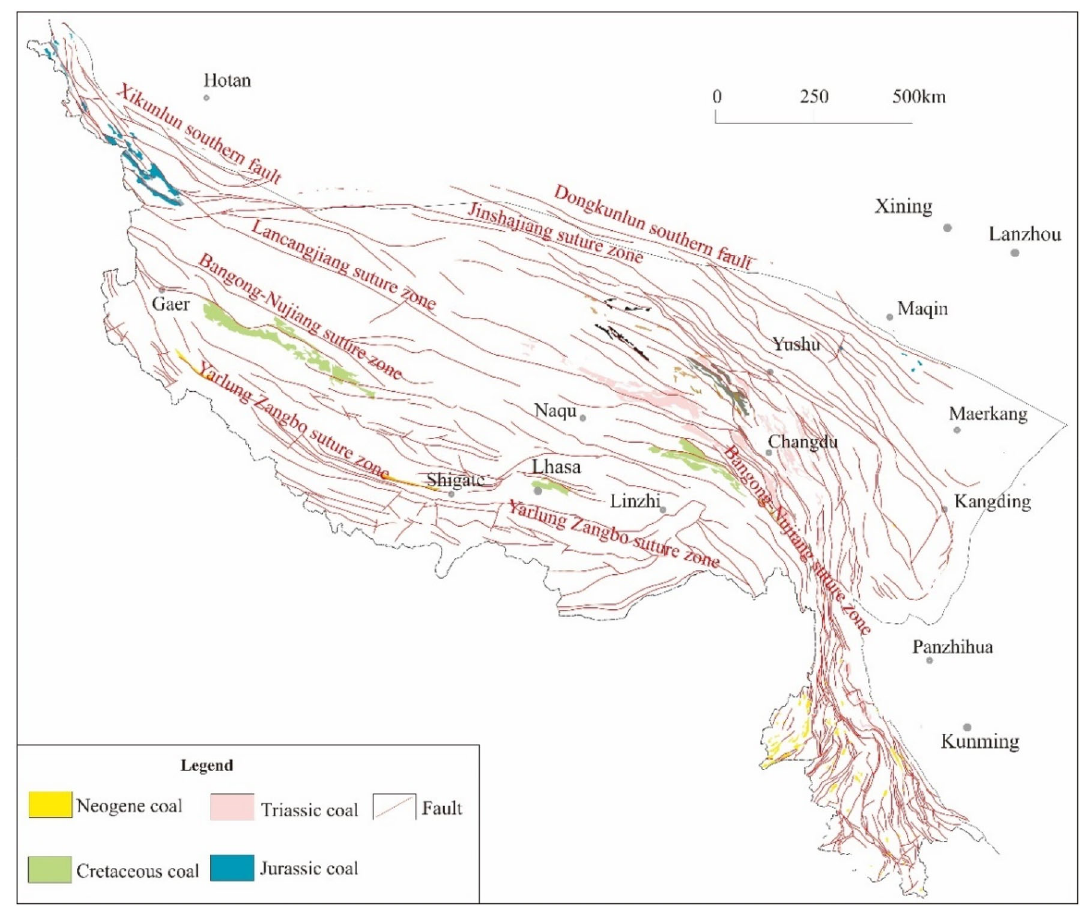
Fig. 15 Diagram of the coalfield structure in the Yunnan–Tibet coal occurrence structural